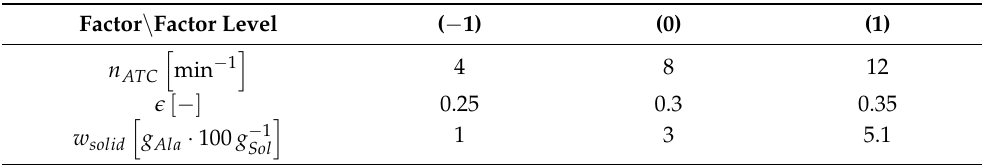
Table 1. Design of Experiments to evaluate hydrodynamics and suspension behavior: rotational speed n ATC , filling degree (cid:101) , and solid content w solid